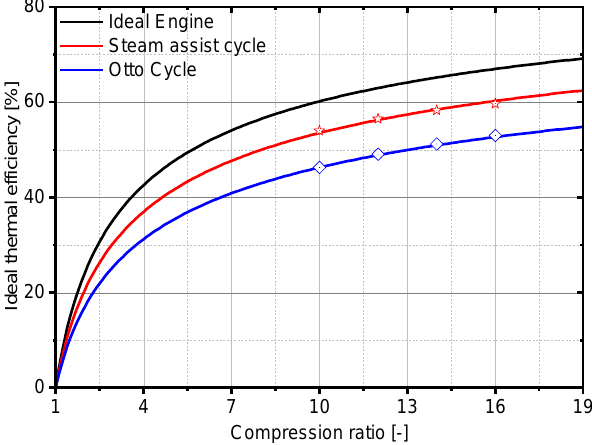
Figure 11. Thermal efficiency boundaries at different compression ratios.